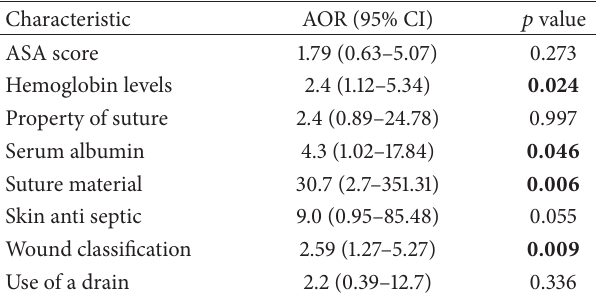
Table 3: Multivariate logistic regression analysis of risk factors for development of